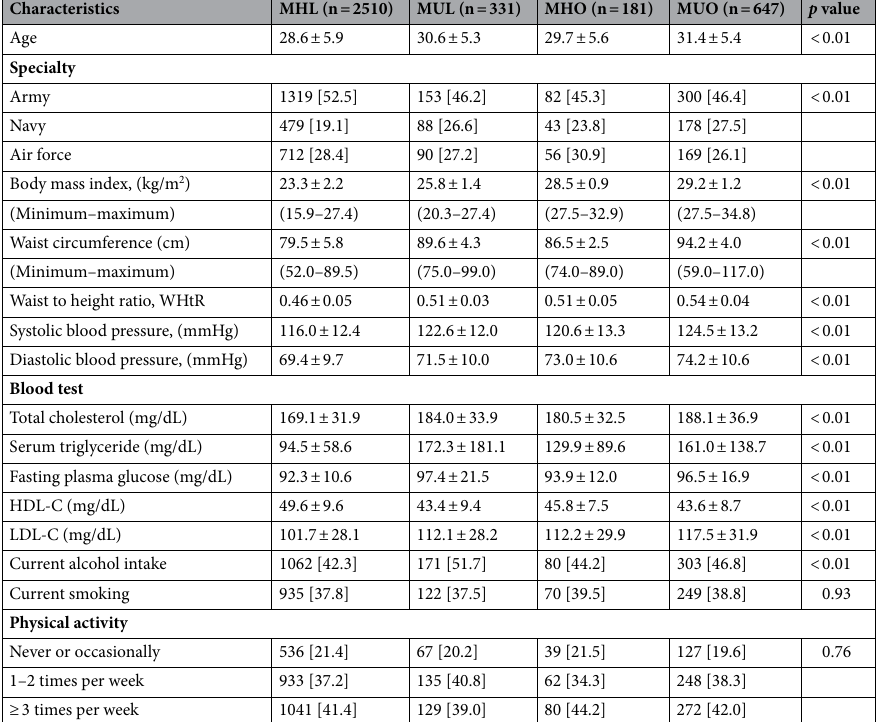
Table 1. Baseline characteristics of the study population (n = 3669). Continuous variables are expressed as mean ± standard deviation, and categorical variables as n [%]. HDL-C, high-density lipoprotein cholesterol; LDL-C, low-density lipoprotein cholesterol. MHL, metabolically healthy lean, defined as body mass index < 27.5 kg/m 2 and absence of two major components of the metabolic syndrome, according to the International Diabetes Federation criteria for Asian male adults; MHO, metabolically healthy obesity defined as body mass index ≥ 27.5 kg/m 2 and absence of two major components of the metabolic syndrome; MUL, metabolically unhealthy lean defined as body mass index < 27.5 kg/m 2 and presence of at least two major components of the metabolic syndrome; MUO, metabolically unhealthy obesity defined as body mass index ≥ 27.5 kg/m 2 and presence of at least two major components of the metabolic